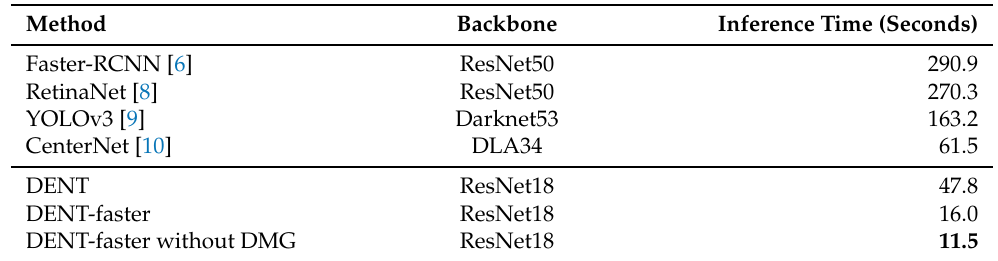
Table 4. Inference time comparison on the Yosemite Tree Counting Dataset. The bold numbers are the lowest values in each